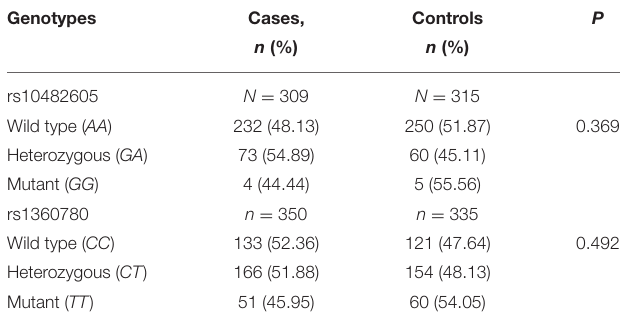
TABLE 3 | Distribution of rs10482605 and rs1360780 genotypes between cases and controls.